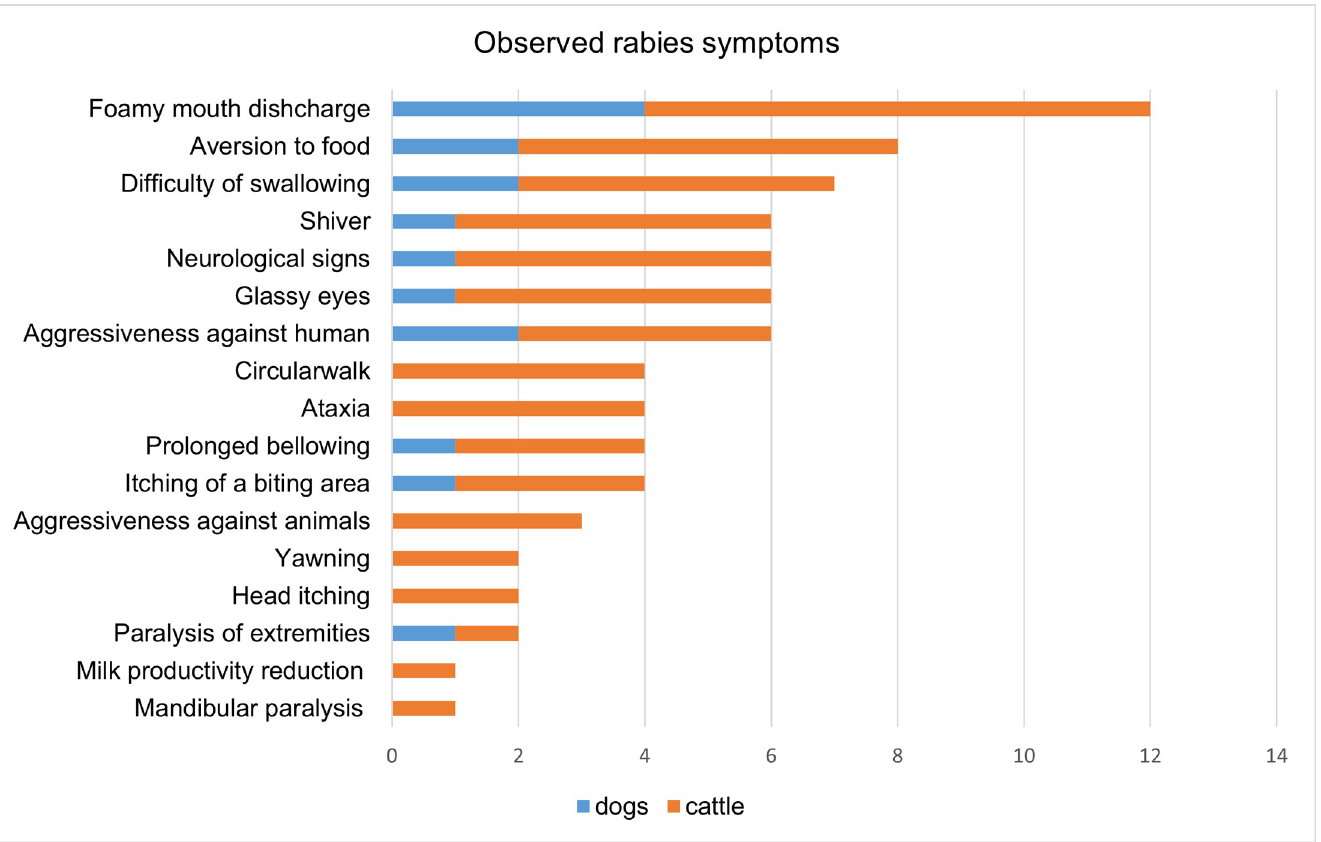
Fig 2. Most common reported symptoms for rabid cattle and dogs by animal owners (N = 20).